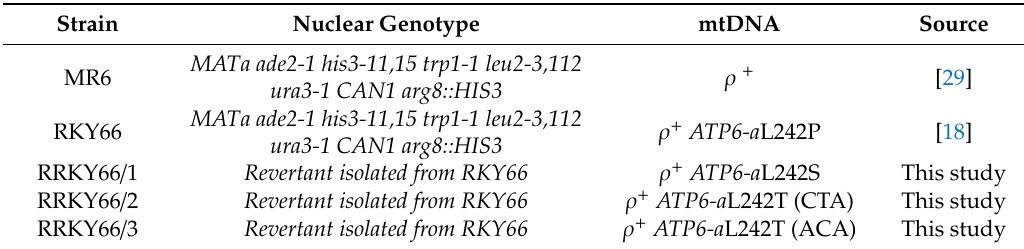
Table 3. Genotypes and sources of the yeast